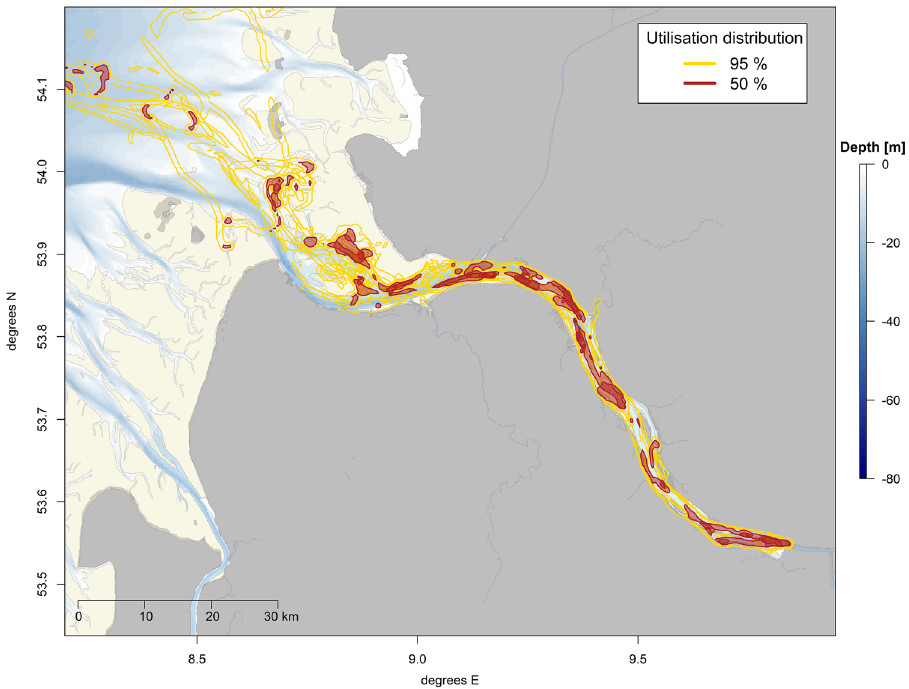
Figure 8. Map showing the overlayed utilisation densities (50%: red, 95%: yellow) of all tagged animals. While the 95% utilisation distribution resembles the overall home range, the 50% utilisation distribution can be regarded as the core area of each seal. Visualisation was done in R! 3.6.2 35 using R Studio 2021.9.0.351 for Windows 36 (https:// cran.r- proje ct. org/ bin/ windo ws/ base/ old/3.